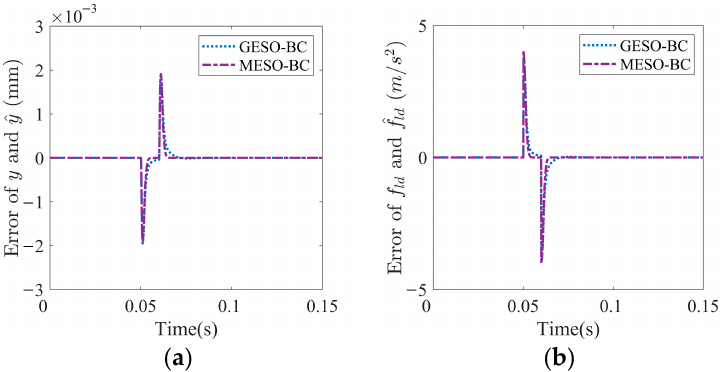
Figure 7. ESO estimation errors: ( a ) Estimation error of y and ˆ y ; ( b ) estimation error of f ld and ˆ f ld .